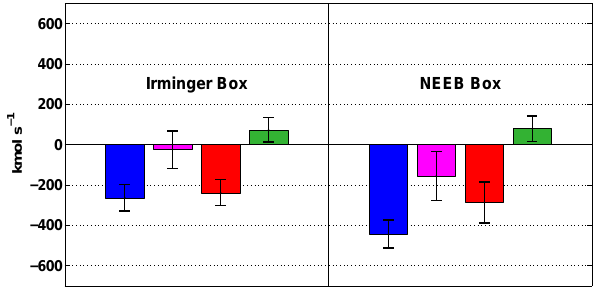
Fig. 4. Abiotic air–sea oxygen flux (kmol s − 1 ) partitioning for the Irminger (left) and NEEB (right) boxes. Note that, here, negative fluxes are into the ocean (ingassing). Blue: abiotic flux, magenta: abiotic mixing flux, red: abiotic thermal flux, and green: biological source/sink term B 0 . The error amplitude is represented on top of each bar.